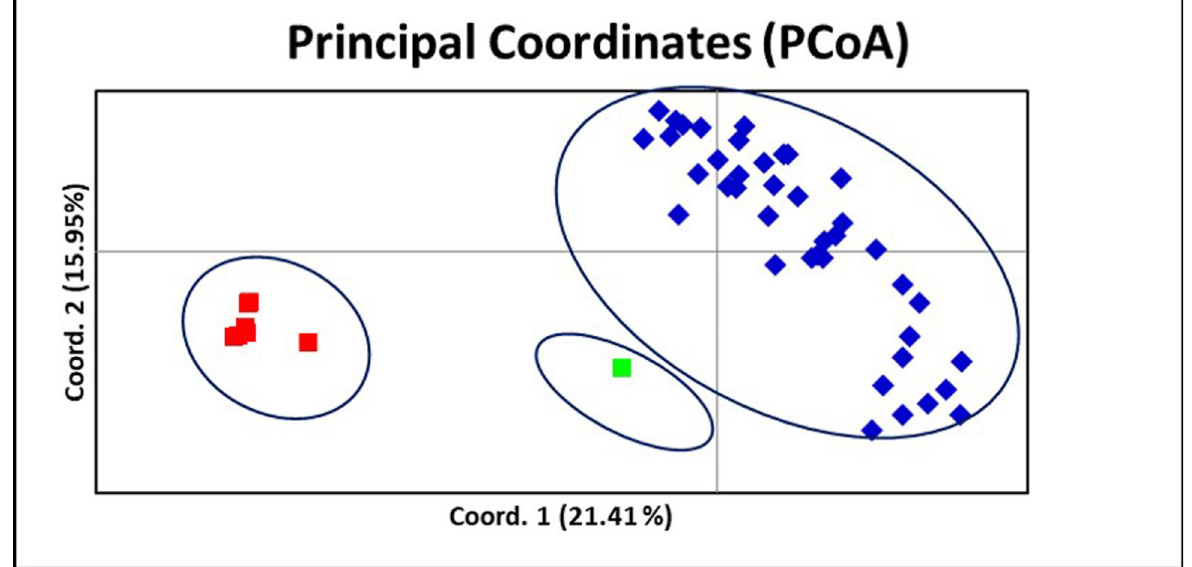
Fig 6. Principle component analysis (PCA) of ginger genotypes based on 12 polymorphic EST-SSR markers.